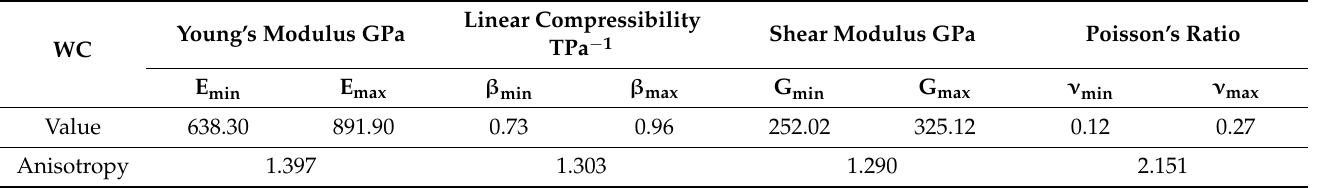
Table 2. Young’s modulus, linear compressibility, shear modulus, and Poisson’s ratio of